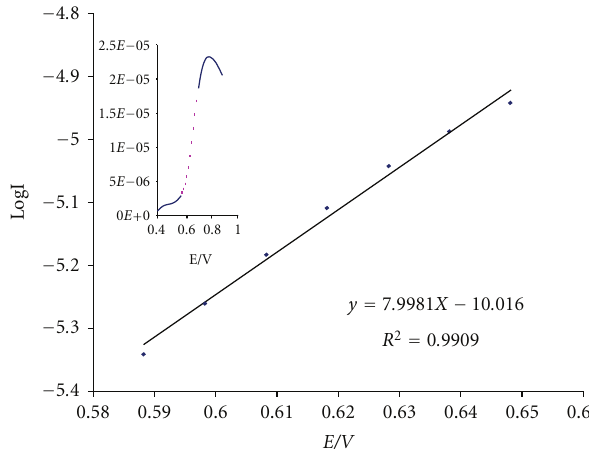
Figure 4: Tafel plot 400 μ M CHP at the surface of MWCNTPE in 0.04 mol L − 1 universal bu ff er (pH 4.0) at a scan rate of 20mVs − 1 in the presence of 150 μ M